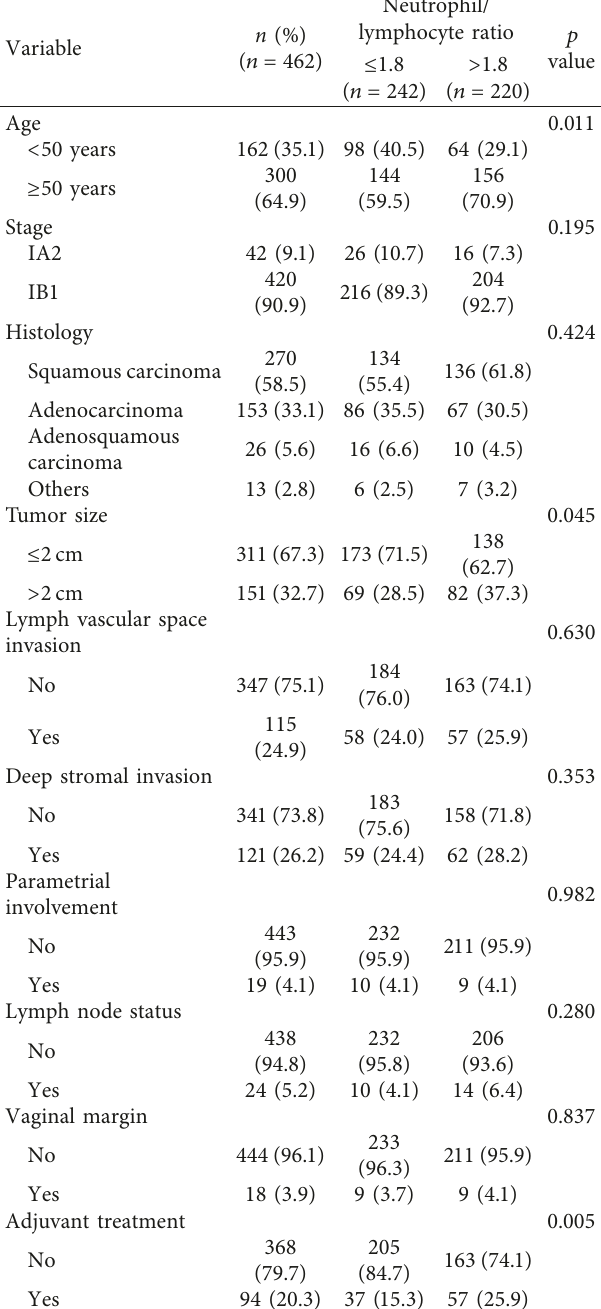
Table 1: Clinicopathological characteristics according to neutro- phil/lymphocyte